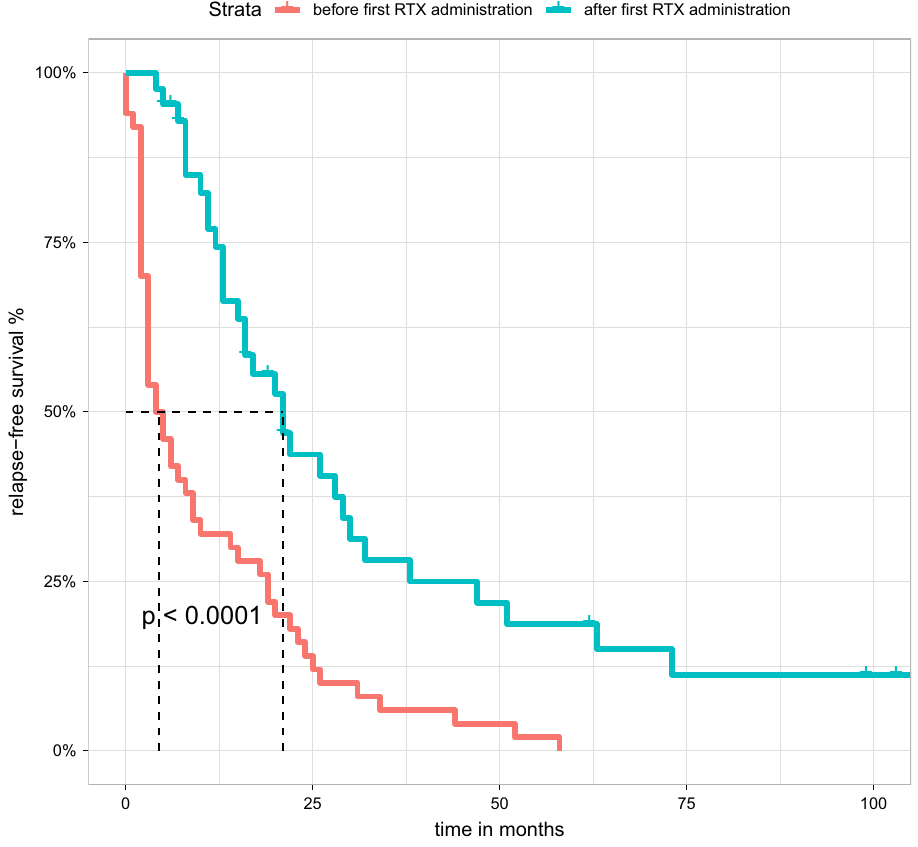
Figure 2. Overall median relapse-free survival improved significantly after the initiation of RTX compared to previous immunosuppression regimens. Patients who were steroid-dependent or steroid-resistant and thus directly relapsed were marked as censored at month